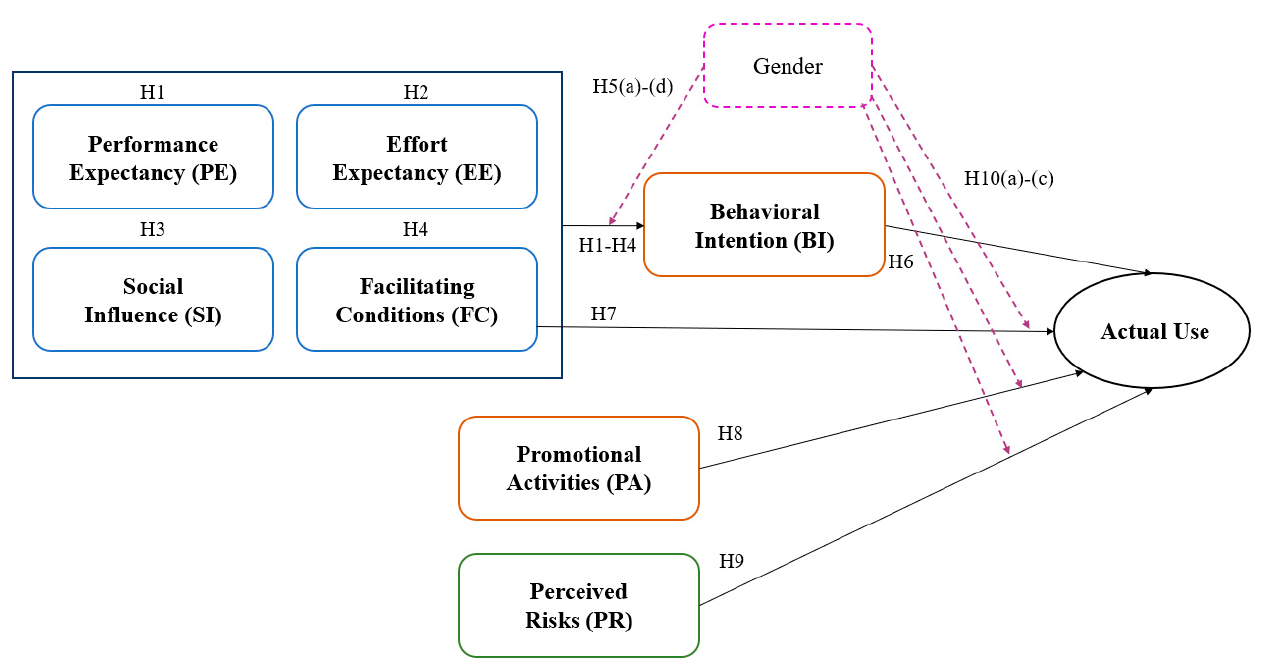
Figure 1. Proposed theoretical model.